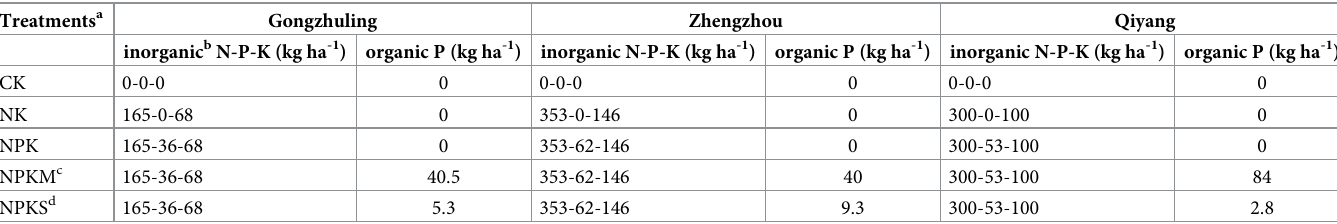
Table 2. Rates of N, P, and K application in the forms of chemical fertilizer and manure at the three long-term fertilizer application sites. Treatments